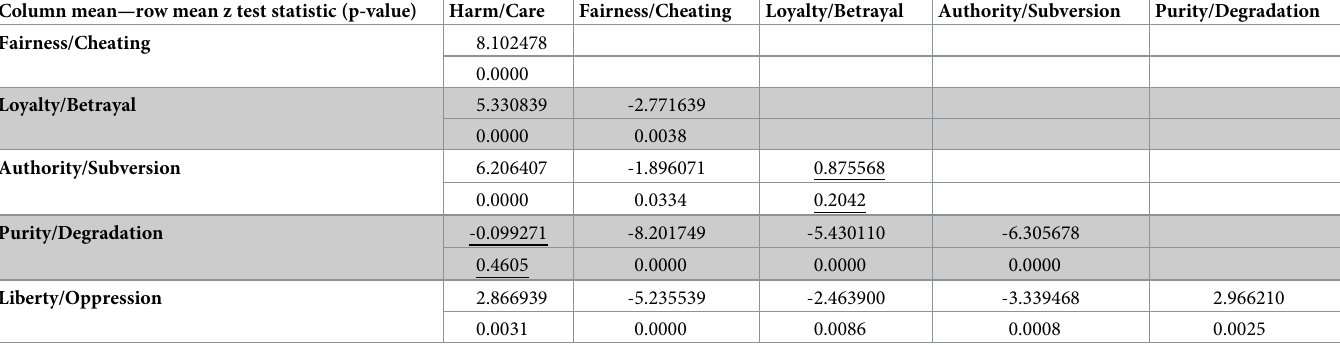
Table 4. Dunn’s pairwise comparison of use of moral foundations by moral foundations (Benjamini-Hochberg). Underlined results are not significant at 5% confi- dence level. Column mean—row mean z test statistic